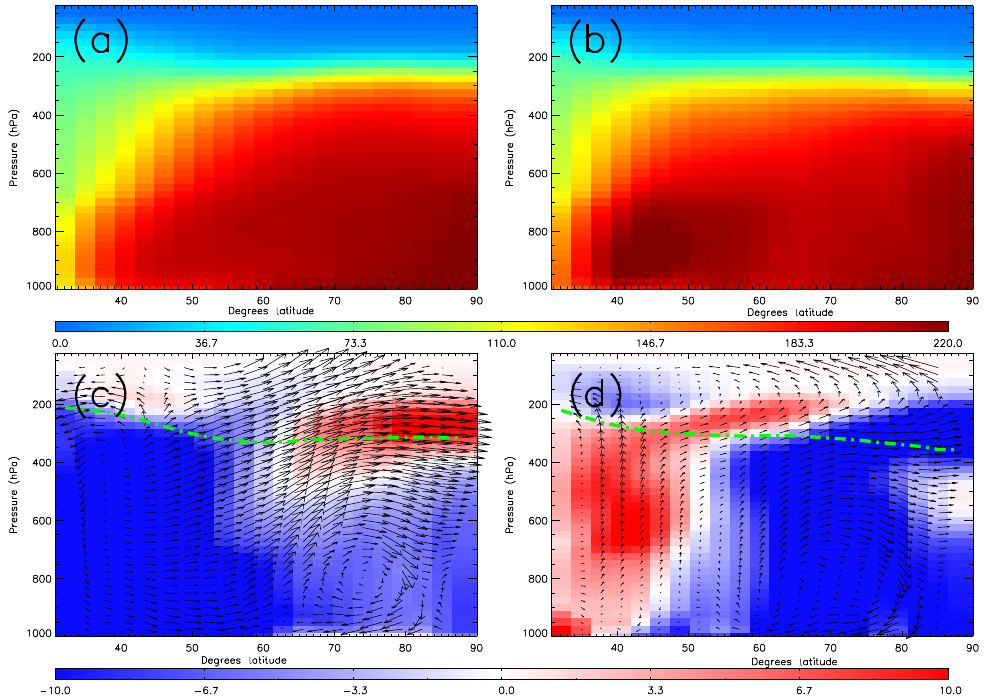
Figure 11. TOMCAT zonally averaged (90 ◦ W to 20 ◦ E) PAN (pptv) between 2006 and 2015 sampled under the wintertime (NDJF) NAO. Panel (a) NAO positive phase, (b) NAO negative phase, (c) shows the NAO positive phase anomaly relative to the wintertime average and (d) shows the negative NAO phase anomaly relative to the wintertime average. Green dashed lines represents the dynamical tropopause. Wind vectors represent the zonally averaged (90 ◦ W to 20 ◦ E) meridional and vertical (scaled by 10 4 )